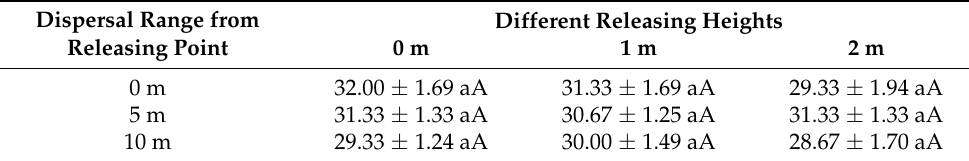
Table 3. Dispersal behavior of Spalangia endius on Bactrocera cucurbitae pupae. Dispersal Range